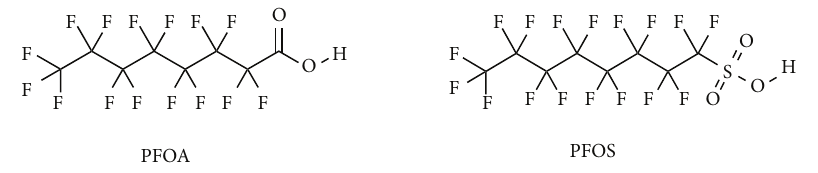
Scheme 1: Structure of PFOA and PFOS.